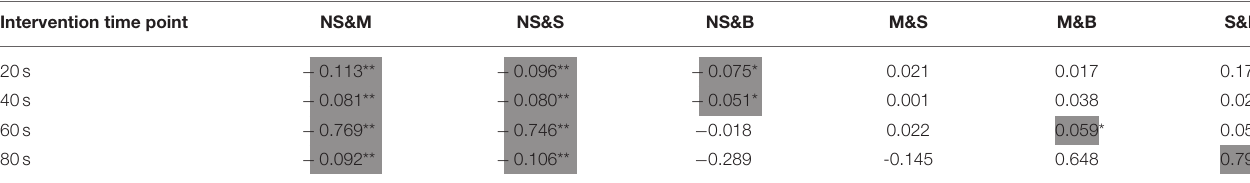
TABLE 4 | The average difference in valence between different sound source types at 20, 40, 60, and 80s during the intervention. Intervention time point NS&M NS&S NS&B M&S